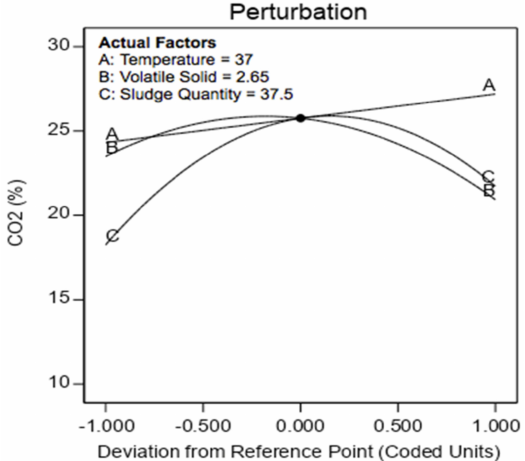
Figure 14. Perturbation plot shows the effect of all factors on CO 2 %.